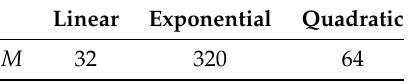
Table 2. Memory requirement comparison.